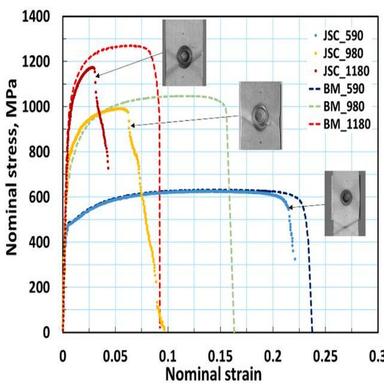
Nominal stress–strain curves for base metal and spot- welded specimens of JSC590, JSC980 and JSC1180.